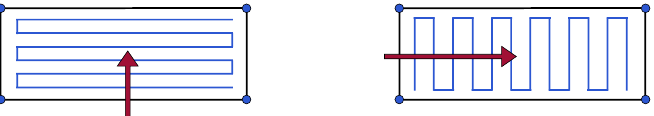
Figure 11. Main orientation (red) of two zigzag